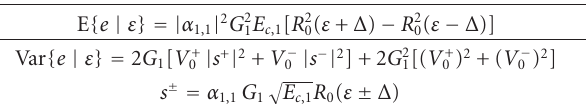
Table 2: Noncoherent TED